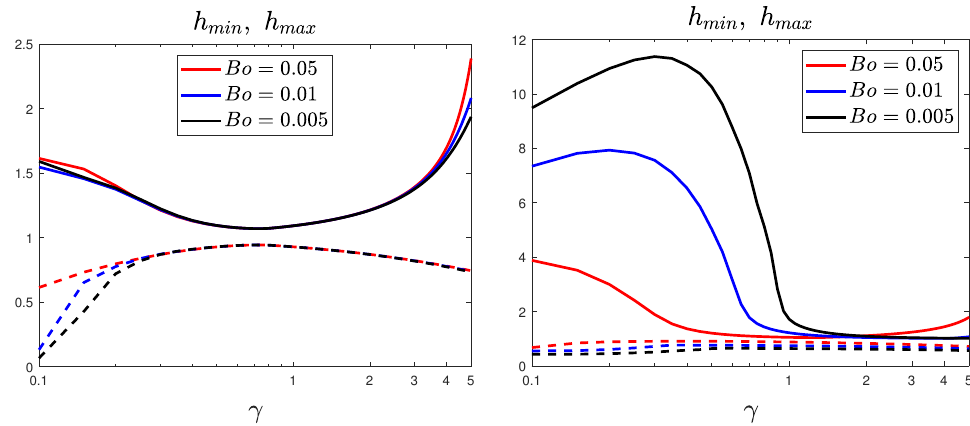
Figure 9. Evolution of the maximum and minimum thickness of the stationary film, as a function of the geometric parameter γ , for Bo = 0.05,0.01,0.005. ( left ) Non-rotating case ( Ω d = 0); ( right ) With rotation at Ω d = 0.2.